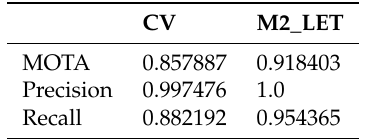
Table 5. Results of the comparison of Computer Vision (CV) and Mask R-CNN base algorithm for plant detection on LET_RTe.